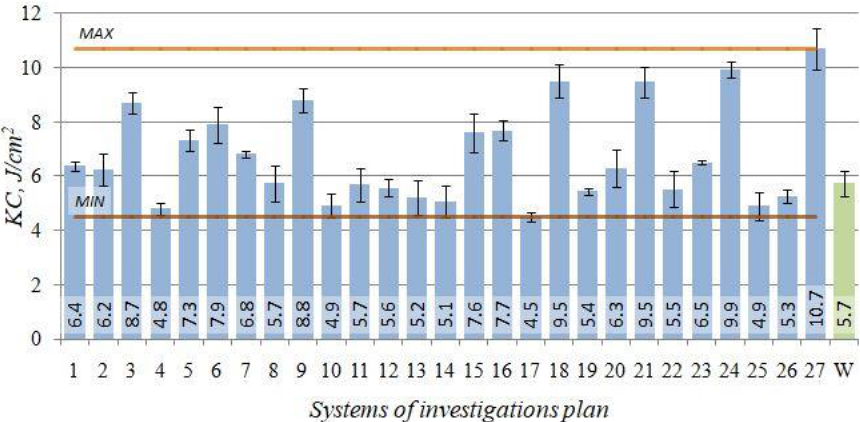
Figure 10. Impact strength KC —the initial state (W) and after T6 heat treatment (1–27) for the EN AC–AlSi1(Fe) alloy.